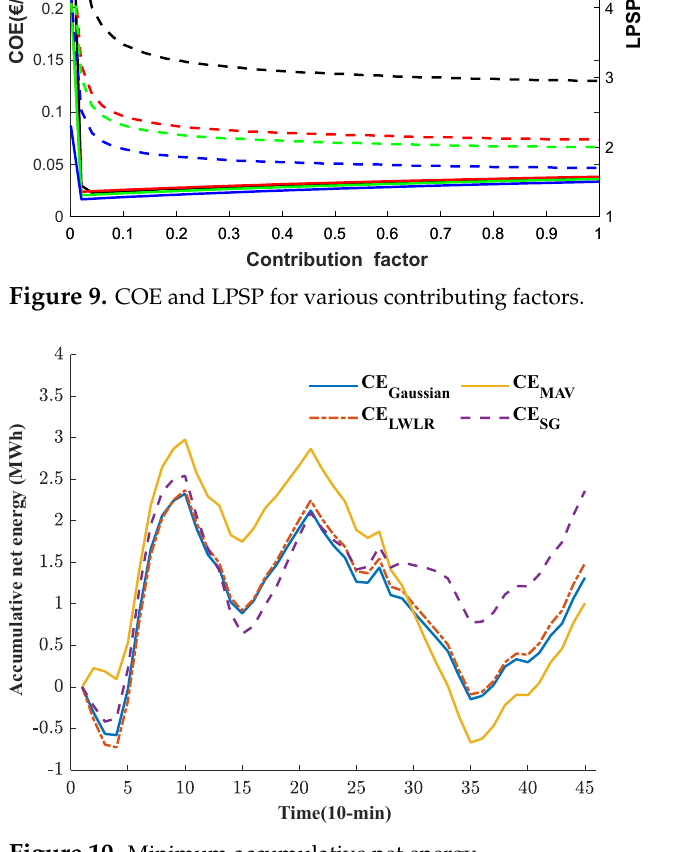
Figure 10. Minimum accumulative net energy. Table 2. Optimal HWSPS configurations based on the suggested method, taking into account various smoothing